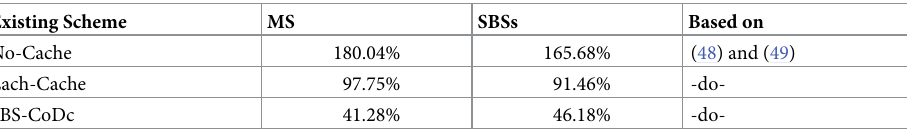
Table 6. Percentage improvement of average EE of MSs and